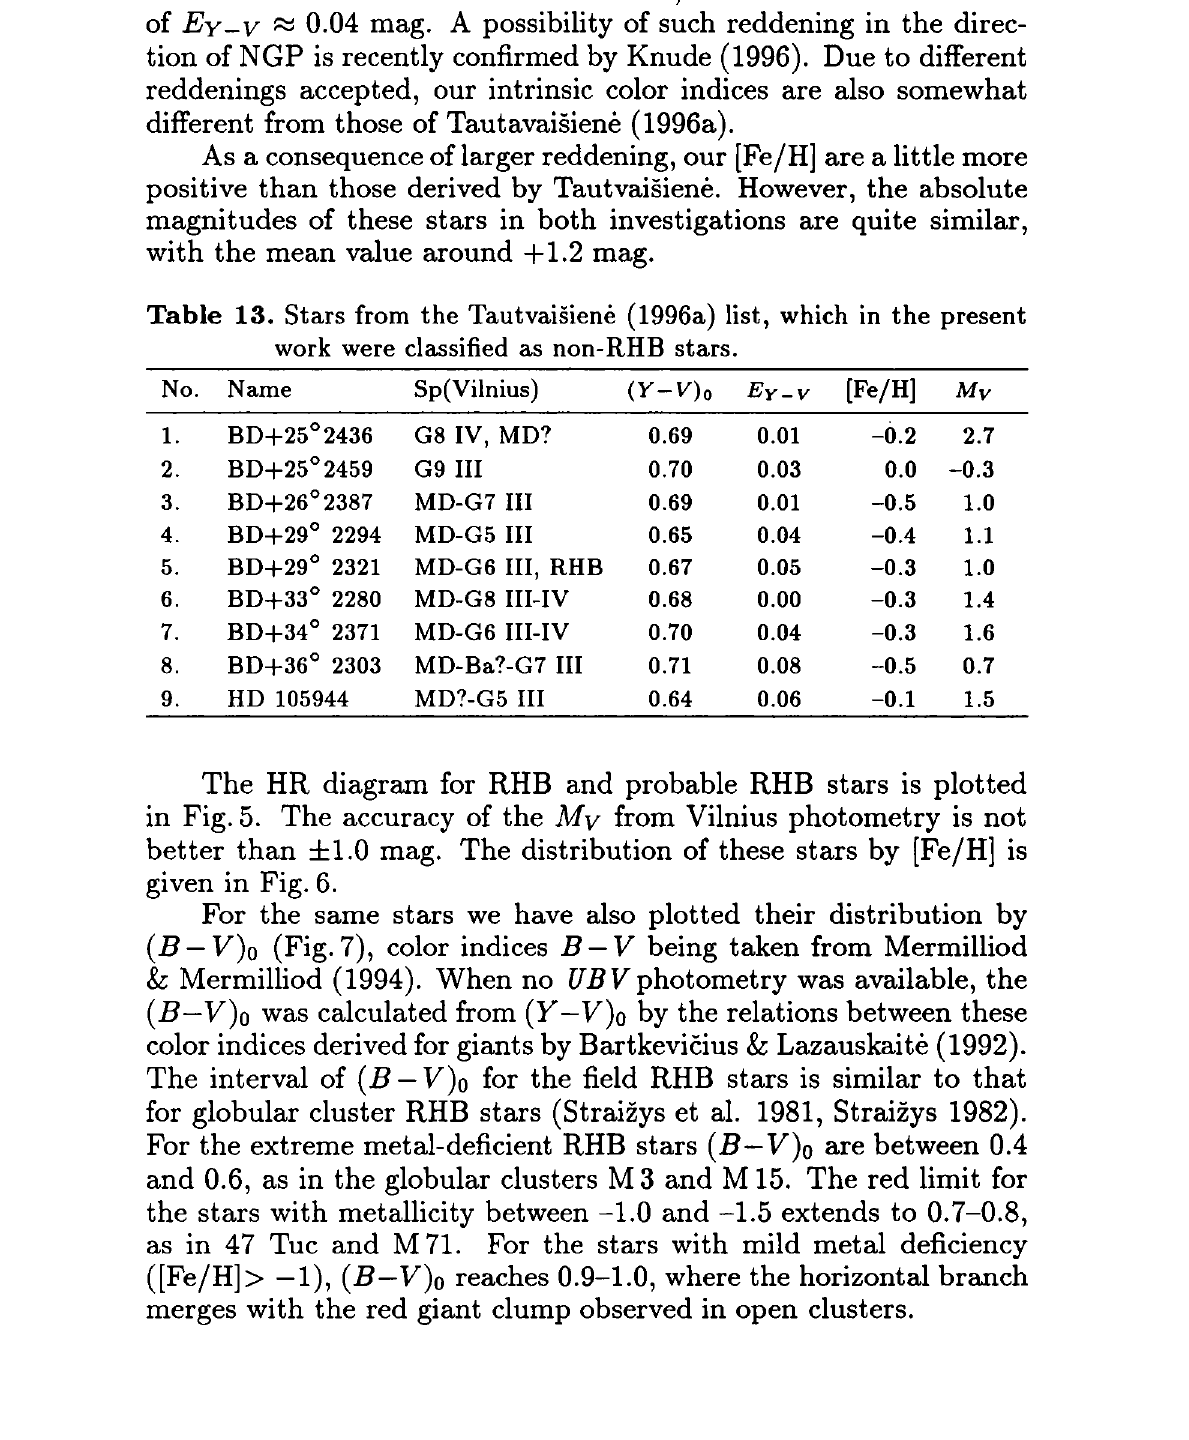
Table 13. Stars from the Tautvaisiene (1996a) list, which in the present work were classified as non -RHB